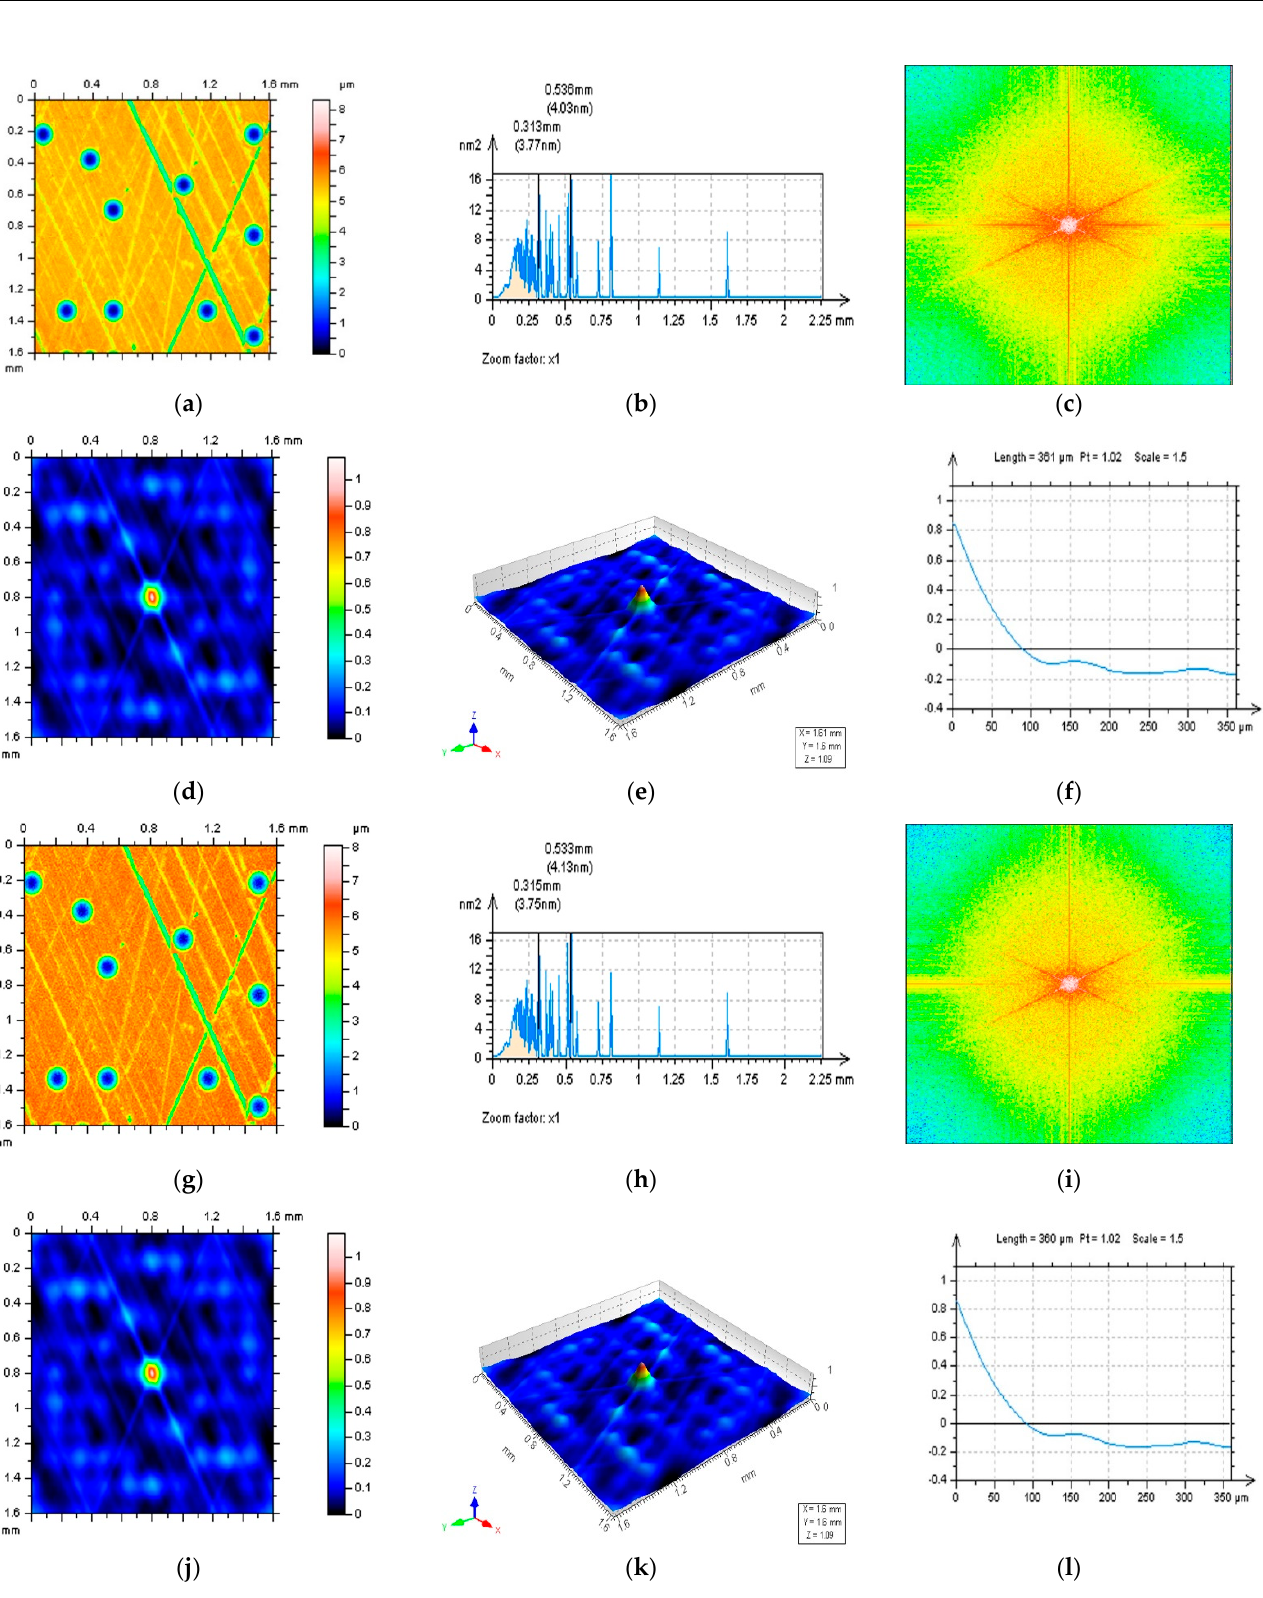
Figure 2. Contour map plots ( a , g ), PSDs ( b , h ), FS ( c , i ) and map plots ( d , j ), isometric view ( e , k ) and centre–profiles ( f , l ) of ACFs received from raw measured data of plateau–honed cylinder liner surface containing oil pockets ( a – f ) and the same surface with a high-frequency noise ( g – l